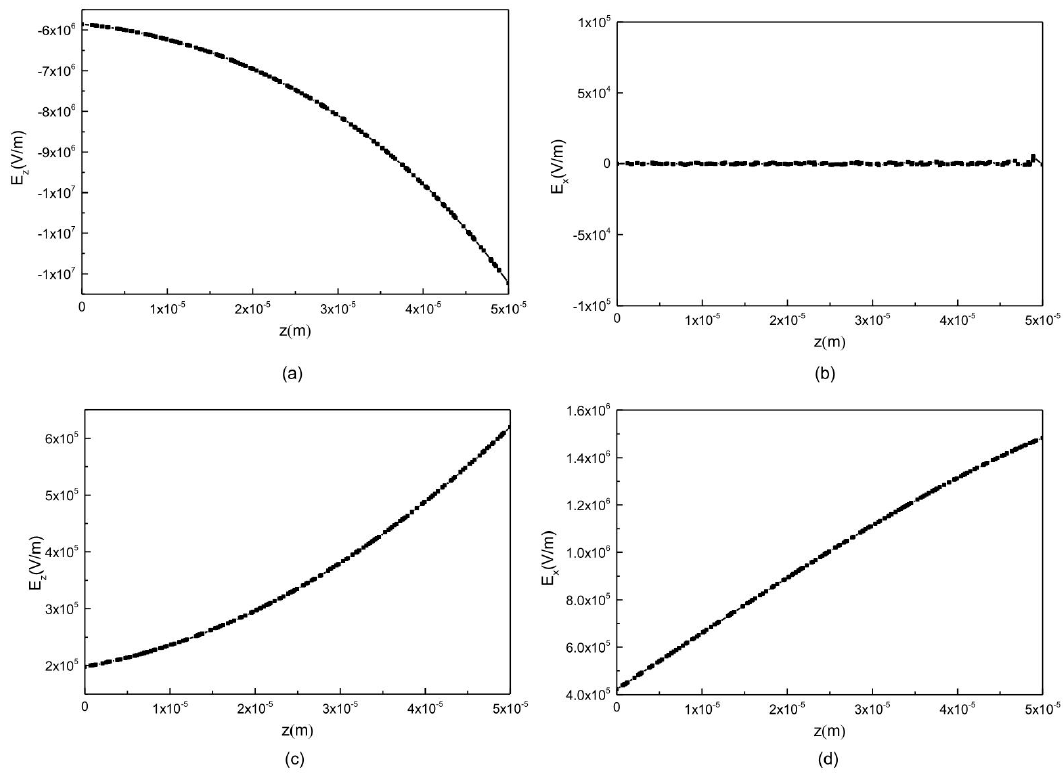
Figure 3. Light-induced electric field components vs z, showing the profile of the electric field through the LC thickness. ( a ) z component perpendicular to the substrates and ( b ) x component parallel to the substrates at the center of the beam x = 0; ( c ) and ( d ) z component and x component at a distance 100 μ m from the beam center. Used data as in Figure 2. z = 0 is located on the x-cut crystal surface in contact with the LC layer, z = L is located on the z-cut crystal surface in contact with the LC layer.